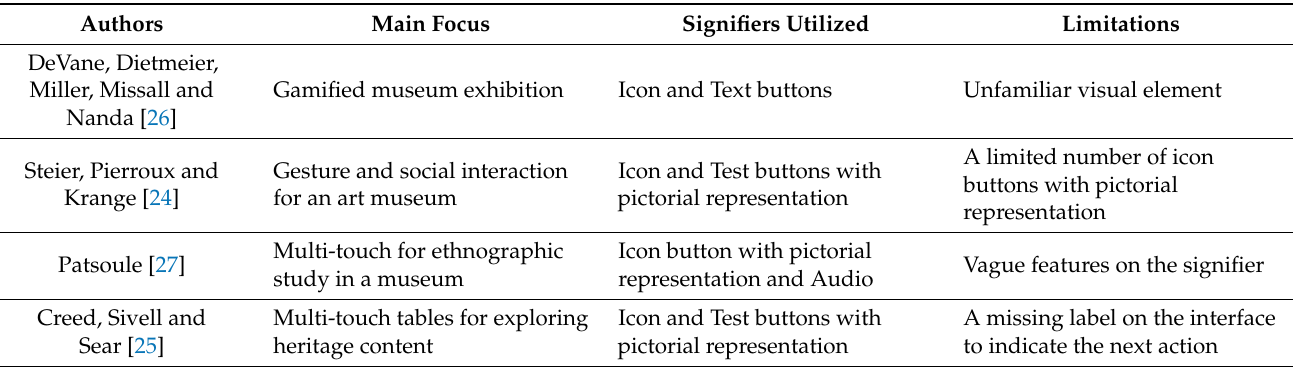
Table 1. Visual signifiers of museum environment for large